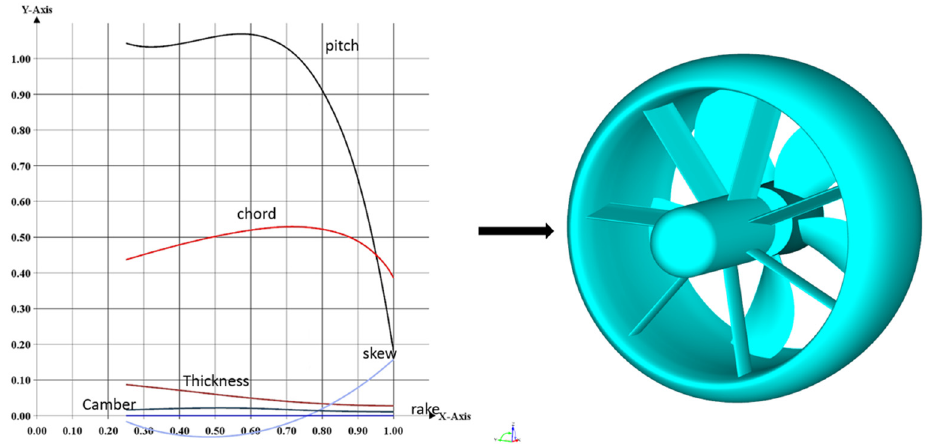
Figure 8. Fully parametric pump-jet model.